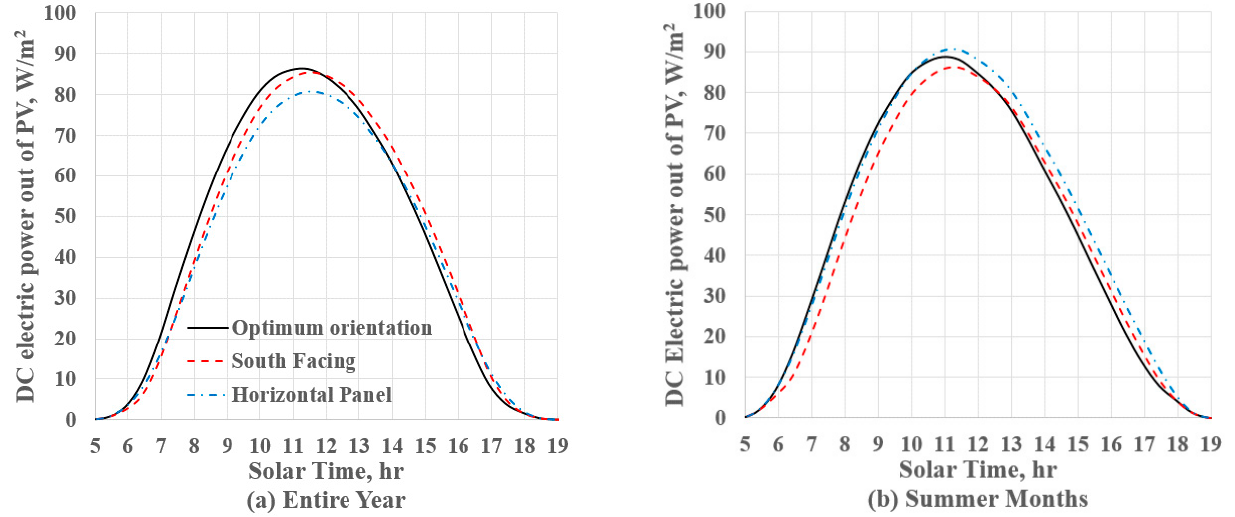
Figure 7. Average daily DC power generation for Orlando Florida, USA. ( a ) For an entire year and ( b ) for summer months (June, July, and August). The three different orientations generate similar power. The horizontal panel provides slightly more power in the afternoon hours. Additionally, the peak power generation is at about 11:00 AM solar time, particularly in the summertime. This is due to more cloud coverage during summer afternoons in Orlando Florida.